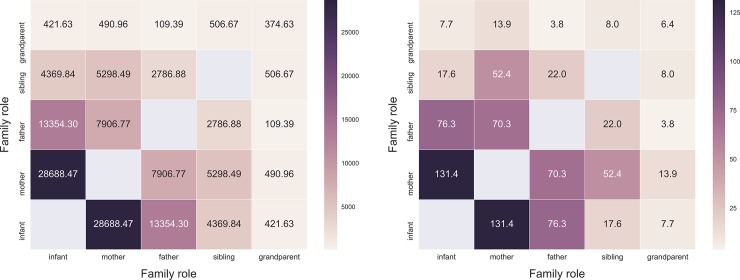
Contact matrices of the mean contact durations per capita (left panel) and the mean contact events per capita (right panel) by roles for all individuals.